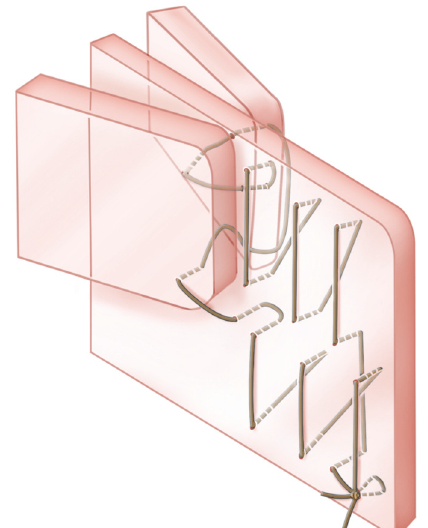
Figure 7: Middle turbinate suturing technique incorporating sep- toplasty quilting